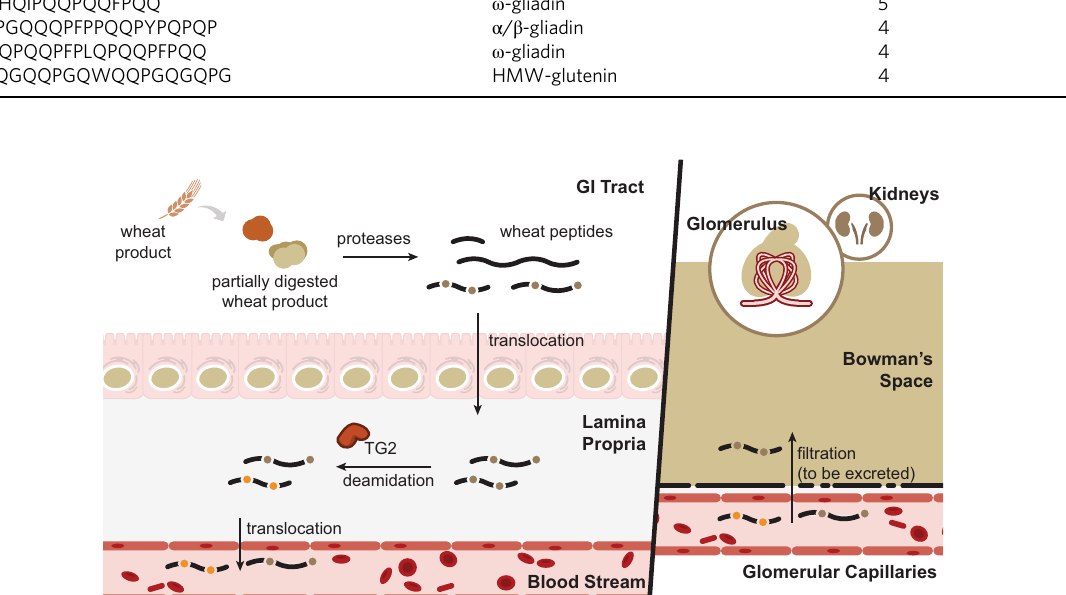
Table 3 Wheat-derived peptide sequences detected in the majority of patients with CeD but not in control groups. Wheat peptide